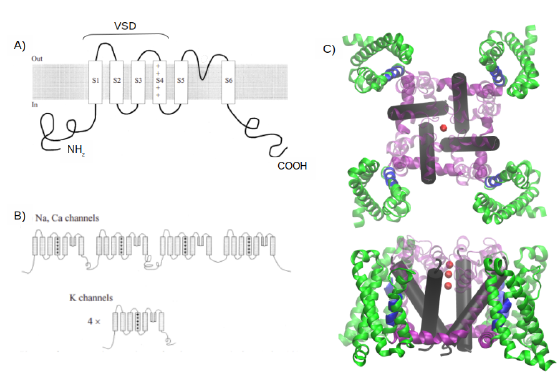
Figure 1. Structural overview of voltage-gated channels. ( A ) Transmembrane disposition of a single voltage-gated K + channel subunit. There are six transmembrane regions, denoted by S1 through S6. ( B ) Structural organization of voltage-gated channels. Na + and Ca 2 + channels have four homologous repeats of the core motif in a single polypeptide chain; K + channels are tetrameric assemblies of subunits with a single core motif. ( C ) A 3D representation of the crystallographic structure of an Arcobacter butzleri RM4018 VGCC in its open state (PDB ID: 4MS2). In green, the four VSD; in blue, the helical conformation 3 10 in the S4 helices; in purple, the S4–S5 helices (not present in ( A ) or ( B )) that connect the S5 and S6 helix; in light purple, the S5 helices and the rest of amino acids that connect to the S6 helix. In black, the cylinders of the S6 helices, and the red spheres represent three calcium